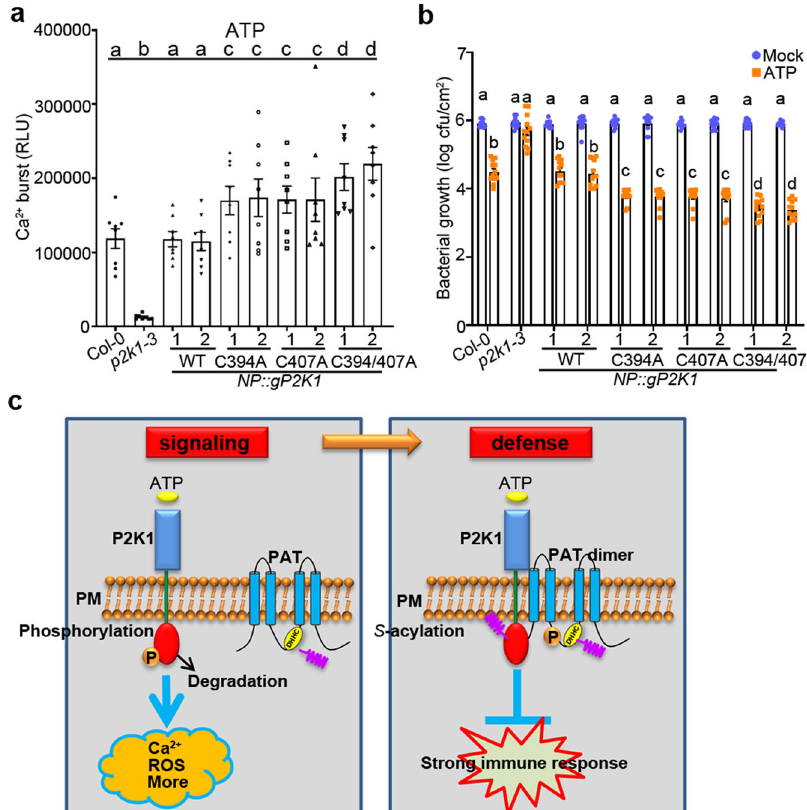
Fig. 6 S -acylation of P2K1 negatively regulates PTI. a , b S -acylation of P2K1 mediates ATP-induced calcium in fl ux and bacterial defense. The indicated 5- day-old seedlings were treated with 100 μ M ATP for calcium in fl ux in 15 min. For bacterial growth, the indicated plant leaves were pretreated with 400 μ M ATP for 24 h, and then inoculated with Pst . DC3000 and bacterial growth measured by plate counting after 3 days post inoculation. Values represent the mean ± SEM, n = 8 in a , n = 12 in b (biological replicates); Means with different letters are signi fi cantly different ( p < 0.05); P -values indicate signi fi cance relative to Col-0 with mock treatment and were determined by one-sided ANOVA with multiple comparisons and adjusted using Benjamini – Hochberg post-test. c Model for the role of P2K1 receptor S -acylation in eATP signaling. Upon addition of the activating ligand eATP, the P2K1 receptor is rapidly autophosphorylation and phosphorylates downstream targets, leading to PTI immune response and P2K1 protein turnover. P2K1 directly interacts with and phosphorylates PATs to activate PATs S -acylation upon ATP treatment. Activation of PATs S -acylates P2K1 and then inactivates P2K1 phosphorylation and turnover, following dampens the immune response to protect plant